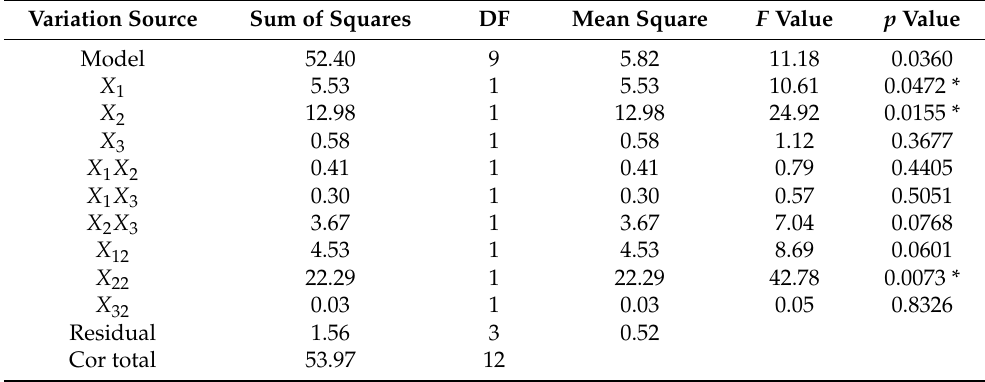
Table 5. Variance analysis results of seedbed preparation machine parameter optimization test for straw coverage